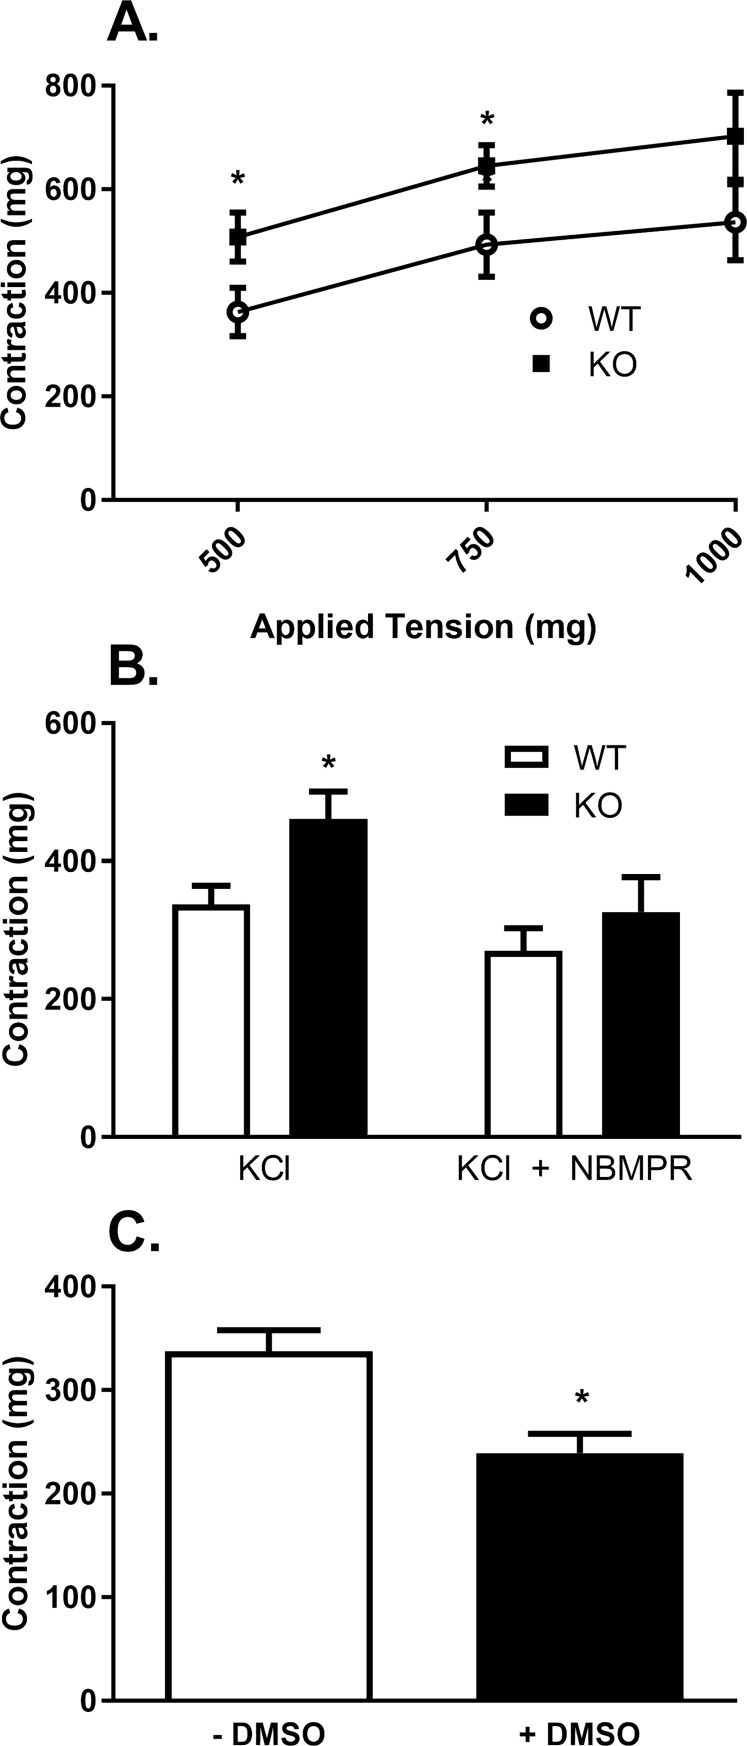
KCl-induced contraction of thoracic aorta from wild-type (WT) and Slc29a1-null (KO) mice.Tissues were incubated for 30 min at 37°C in KPSS buffer at resting tensions of 500 mg, 750 mg and 1000 mg. Following equilibration period, 100 mM KCl was administered to assess tissue viability (Panel A). Each point represents the mean ± SEM, N = 6. Panel B shows the effect of NBMPR on KCl-induced contractions of the thoracic aorta from wild-type and Slc29a1-null mice. Tissues were incubated for 30 min at 37°C in KPSS buffer at resting tensions of 500mg in the absence and presence of 1 μM NBMPR, and then 100 mM KCl was administered. Each bar represents the mean ± SEM, N = 7. NBMPR was prepared in DMSO with a final concentration of DMSO in the tissue bath of 0.1% v/v. Panel C shows the effect of 0.1% DMSO alone on the KCl-induced contraction of wild-type thoracic aortas (N = 5). *Significant difference between aortas from wild-type and Slc29a1-null mice (Panel A and B) or ± DMSO (Panel C) (Student’s t-test, * P<0.05).